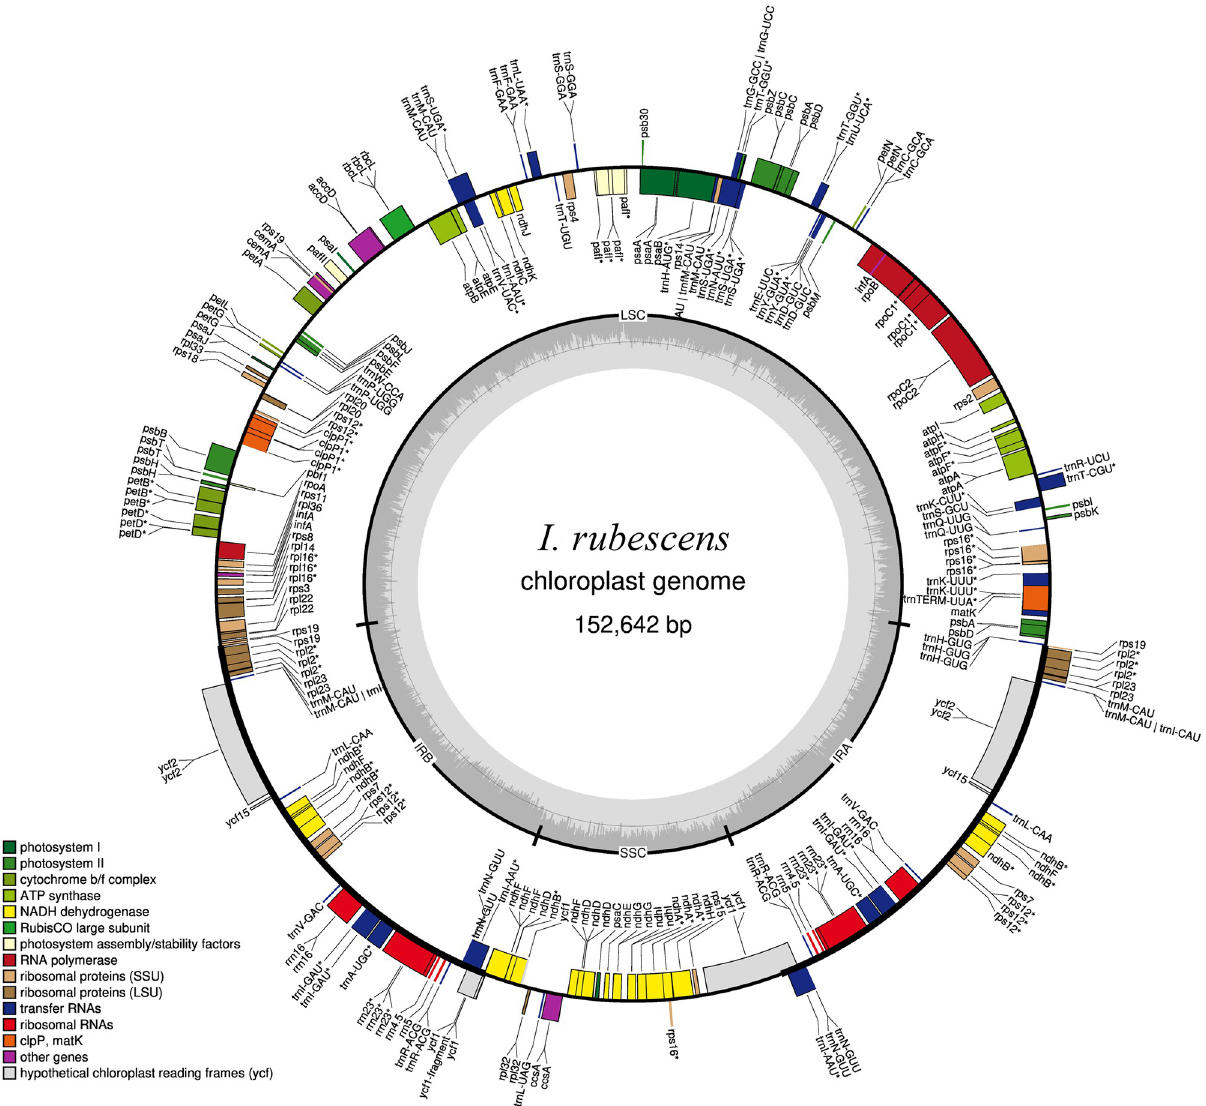
Fig 1. Circular gene map of the I . rubescens chloroplast genome. Genes inside the circle are transcribed clockwise, and those outside are transcribed counter clockwise. Groups of genes with different functions are color-coded. The darker gray in the inner circle shows the GC content, while the lighter gray shows the AT